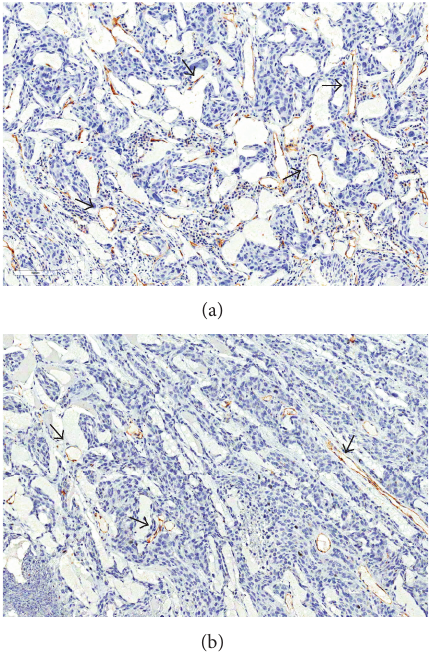
Figure 5: Representative microvessel density (MVD) of (a) control and (b) treatment groups: immunostaining with CD31 antibody highlights vessels (arrows). Intratumoral MVD of the right tumor of the rabbit number 5 (control group) is 26.25 and the left tumor of the rabbit number 2 is 9.25 (original magnification, ×